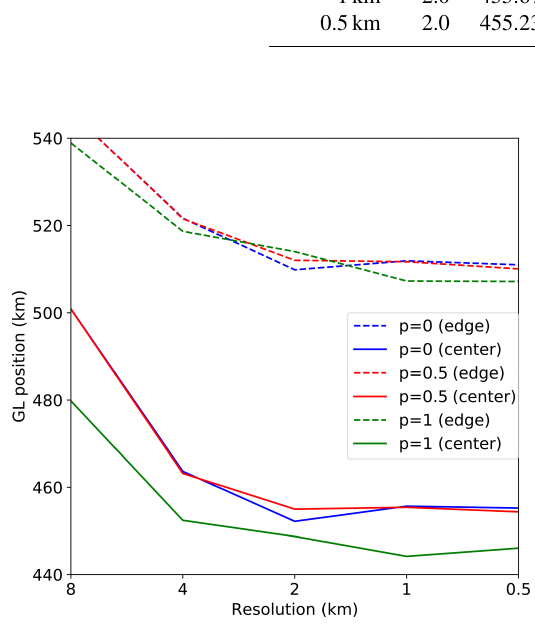
Figure 9. Grounding line location (km) as a function of grid reso- lution (km) at the end of the spin-up, using the MISMIP+ experi- mental setup. Results are shown for p = 0 (blue), p = 0 . 5 (red), and p = 1 (green) at the edge (dashed lines) and center (solid lines) of the domain.